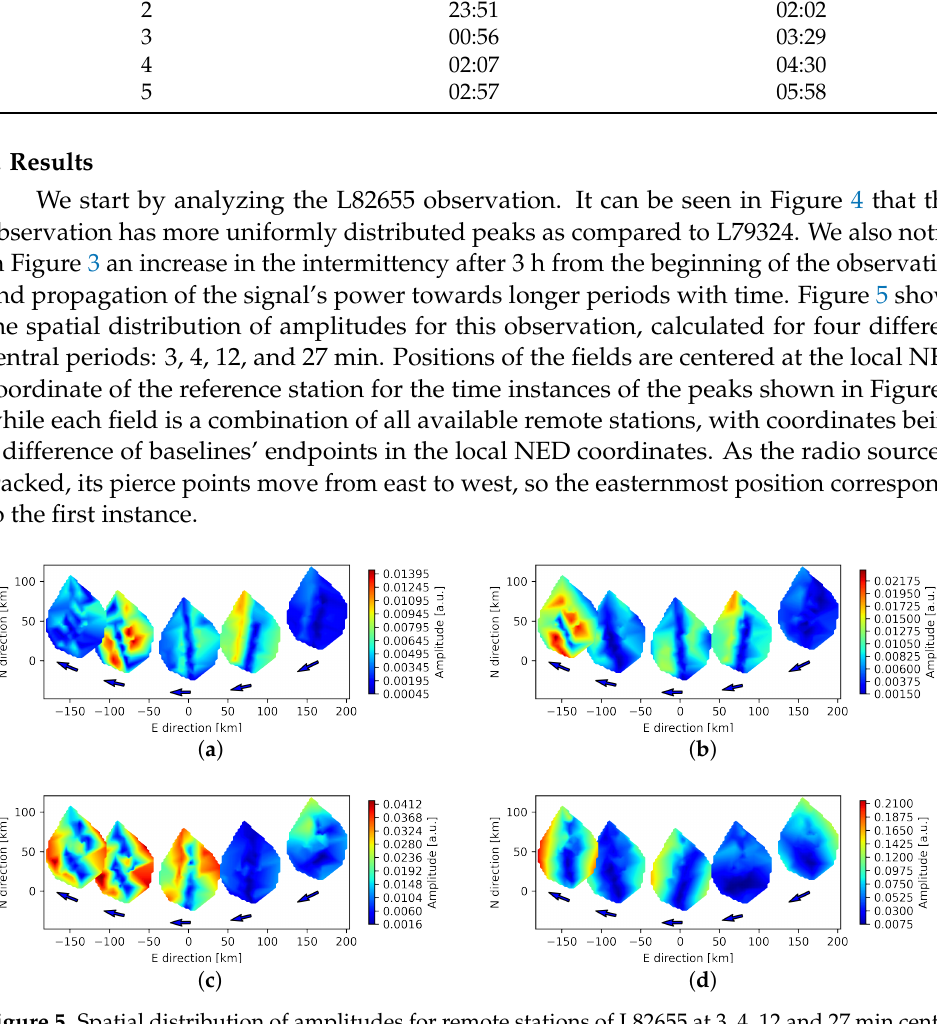
Figure 5. Spatial distribution of amplitudes for remote stations of L82655 at 3, 4, 12 and 27 min central periods (panels ( a – d ), respectively). Arrows indicate the direction of LOS